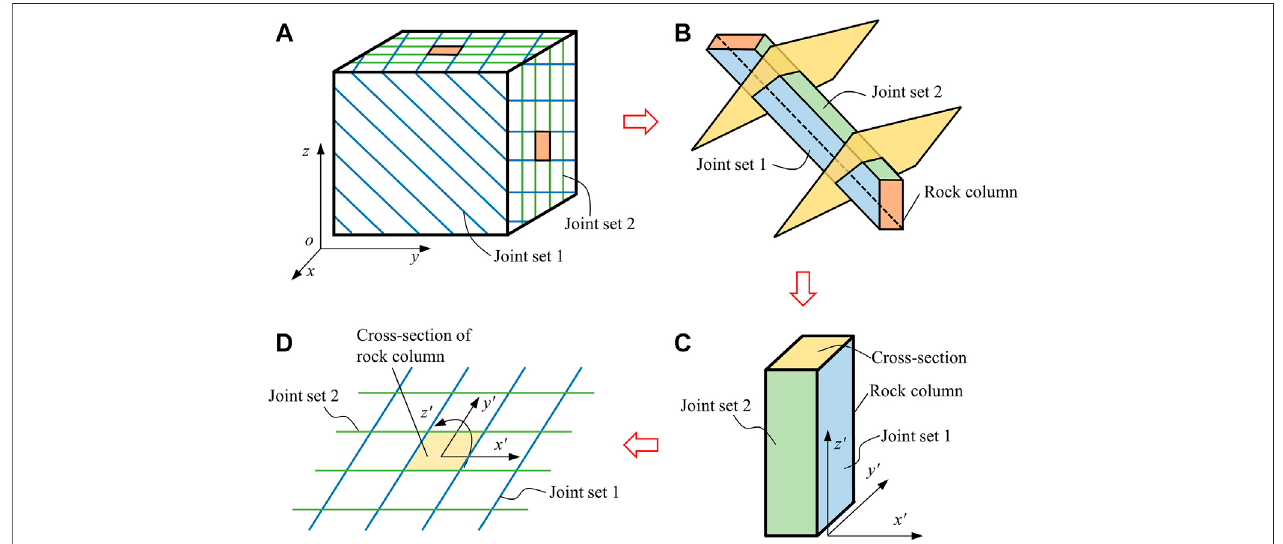
FIGURE 1 | Method for establishing the local coordinate system of